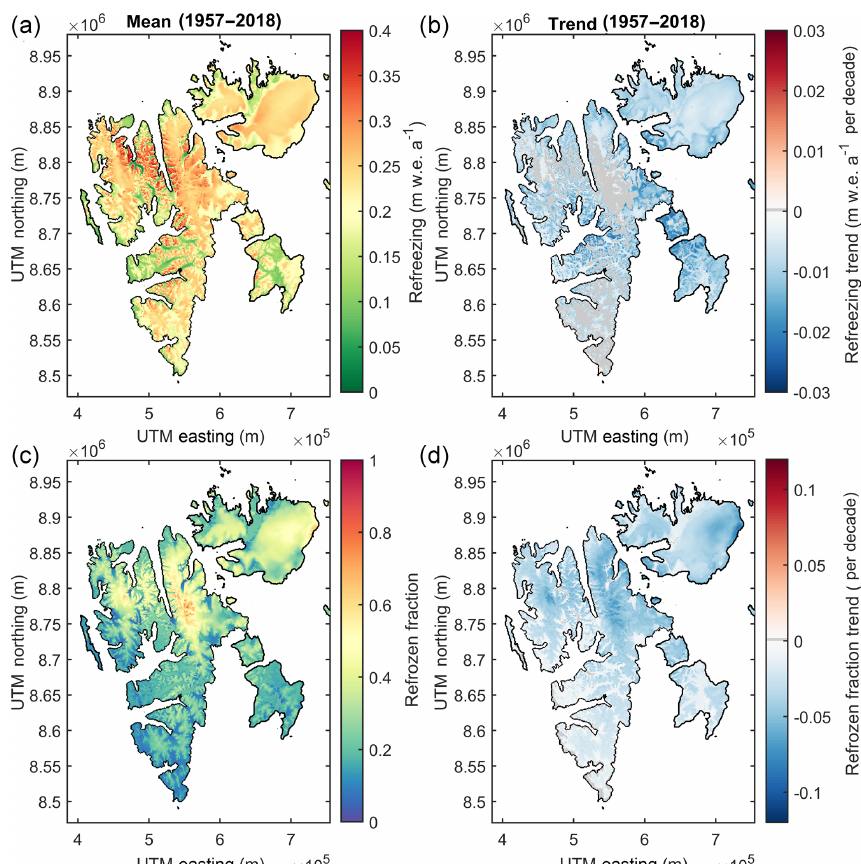
Figure 9. Long-term mean spatial refreezing distribution (a) and trends (b) . Long-term mean spatial refrozen fraction distribution (c) and trends (d)